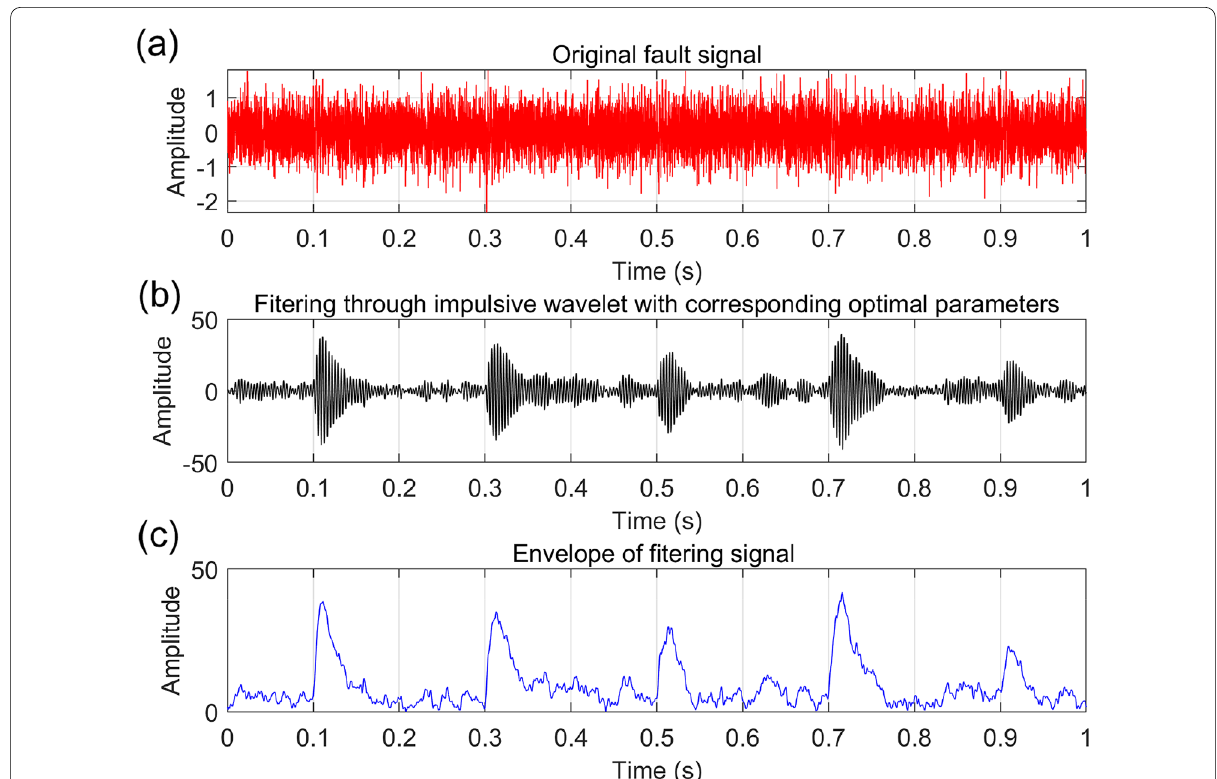
processed signal